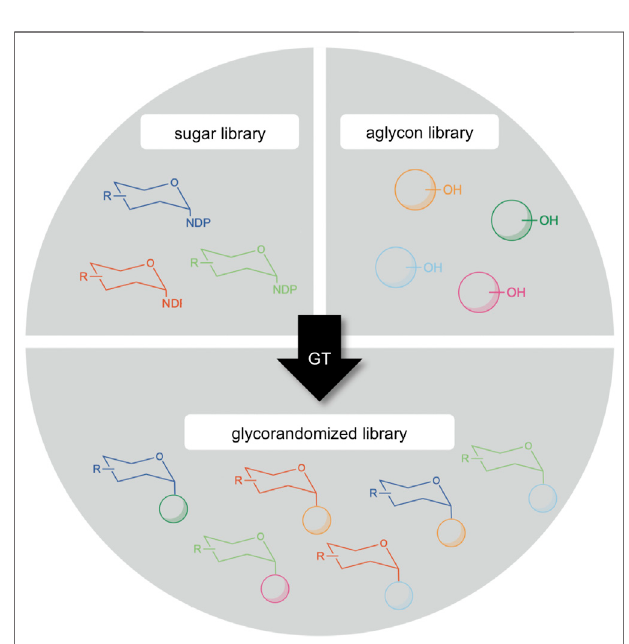
FIGURE 7 | Creation of a glycorandomized library by glycosyltransferases (GT) through the diversi fi cation of sugar donor and/or acceptor (aglycon)